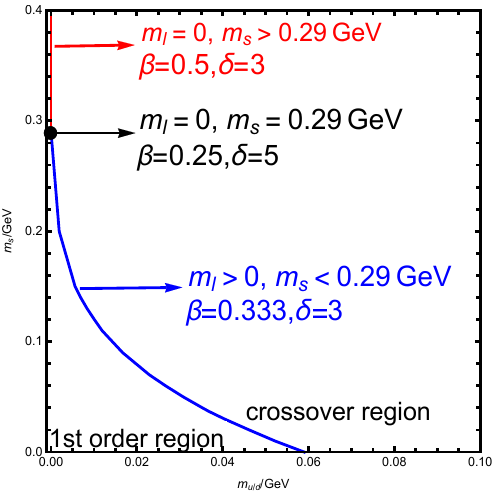
Figure 7 . The mass plane ( m m s ) phase diagram. The lower left corner is first order transition u/d − region. The upper right corner is crossover region. The critical line are divided by a tri-critical point m l,tri = 0 , m s,tri = 0 . 290 . . . GeV. The blue segment of the critical line has the critical exponents β = 1 0 . 333 , δ = 3, while the red segment takes the value β = 1 = 0 . 5 , δ = 3. At the tri-critical 3 ≈ 2 = 0 . 25 , δ = point, β = 1 4